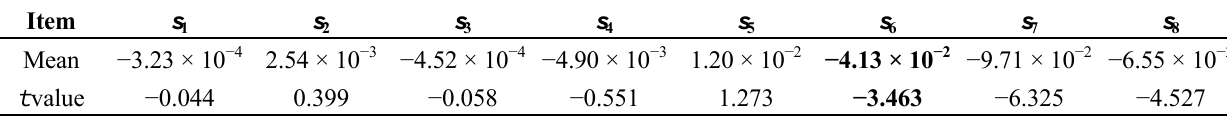
s and t value of DEC10. i